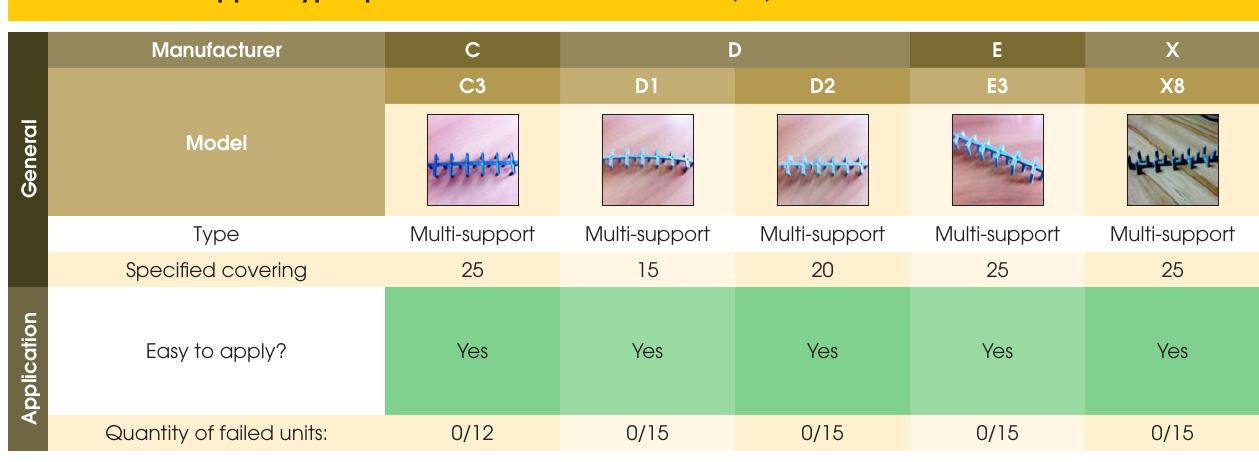
Table 27 – Results of the application requirement evaluation of